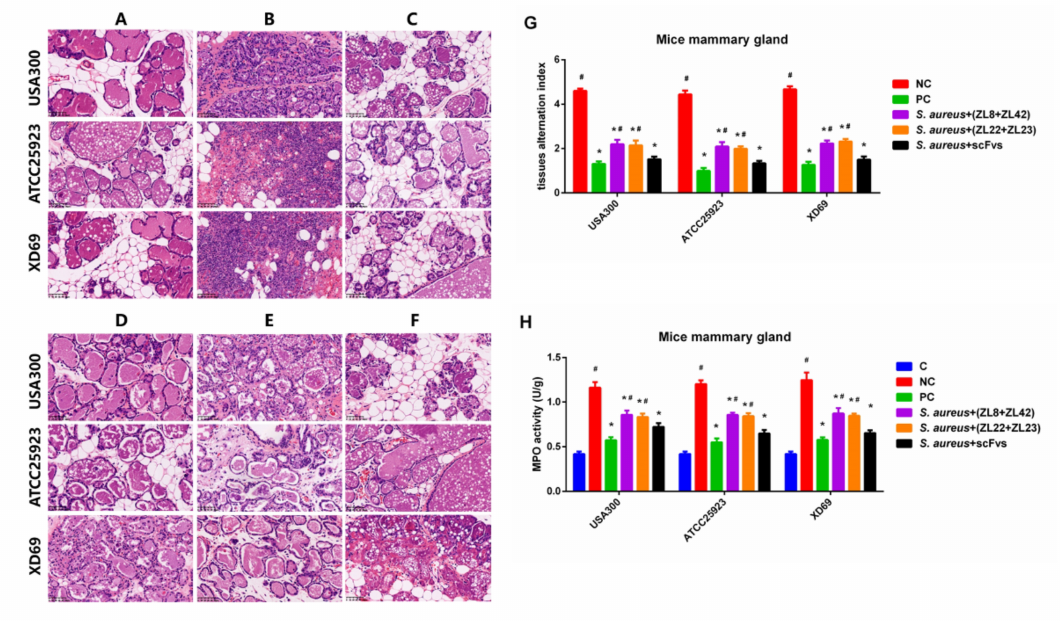
Figure 7. Functions of scFvs on histopathological changes and bovine neutrophils infiltration in S. aureus -induced mammary gland tissues. ( A ) Control group. ( B ) NC group. ( C ) PC group. ( D ) ZL8+ZL42 group. ( E ) ZL22 + ZL23 group. ( F ) scFvs mixture group. ( G ) Tissue alteration index of mammary gland tissues. ( H ) MPO activity assay of mammary gland tissues. Data represent the mean results ± SD ( n = 6). # p < 0.05 vs. the scFvs mixture group. * p < 0.05 vs. the NC